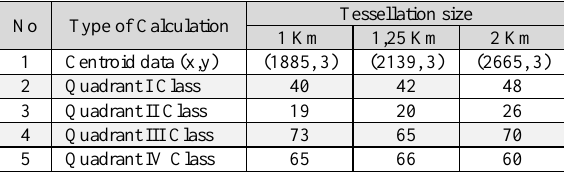
Table 4.3 Result of mathematical calculation of